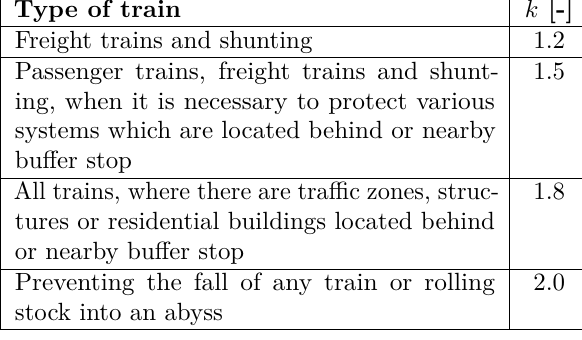
Table 2. Safety coefficient [6].